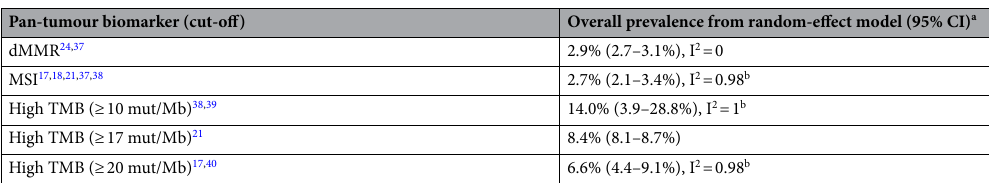
Table 1. Overall pan-cancer prevalence of dMMR/MSI/high TMB in adult solid tumours. dMMR mismatch repair deficiency, MSI microsatellite instability, TMB tumour mutational burden, CI confidence interval. a Estimates for pan-cancer biomarker prevalence were considered based on studies that included ≥ 10 solid cancer types, excluding haematologic tumours and lymphomas. Heterogeneity across studies was presented based on the point estimate of I 2 score and heterogeneity test, if ≥ 2 records were available for each pan-tumour biomarker. b Statistically significant heterogeneity across studies (p < 0.05). Another paper (Shemesh et al. 20 ) reported the prevalence of high TMB (≥ 16 mut/Mb) based on the analysis of seven studies evaluating the efficacy and safety of atezolizumab monotherapy. As four of the seven studies included locally advanced or metastatic cancers only, contributing 1671/2894 individuals to the pooled analysis, the pooled estimate (17.7%, 95% CI 15.4–20.2%) may not be directly comparable with other non-stage-specific estimates and was not included in the table for overall